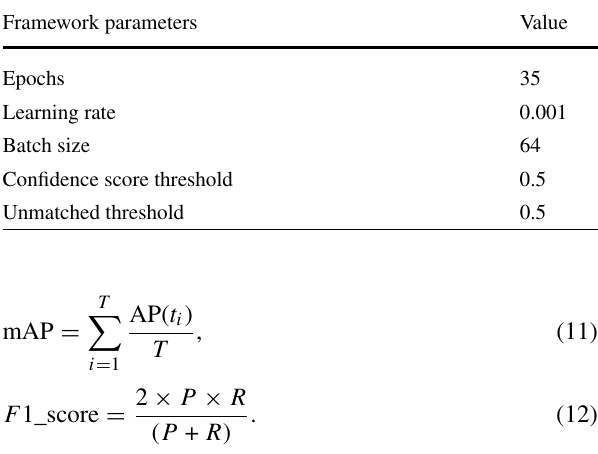
Table 3 Training parameters for the proposed